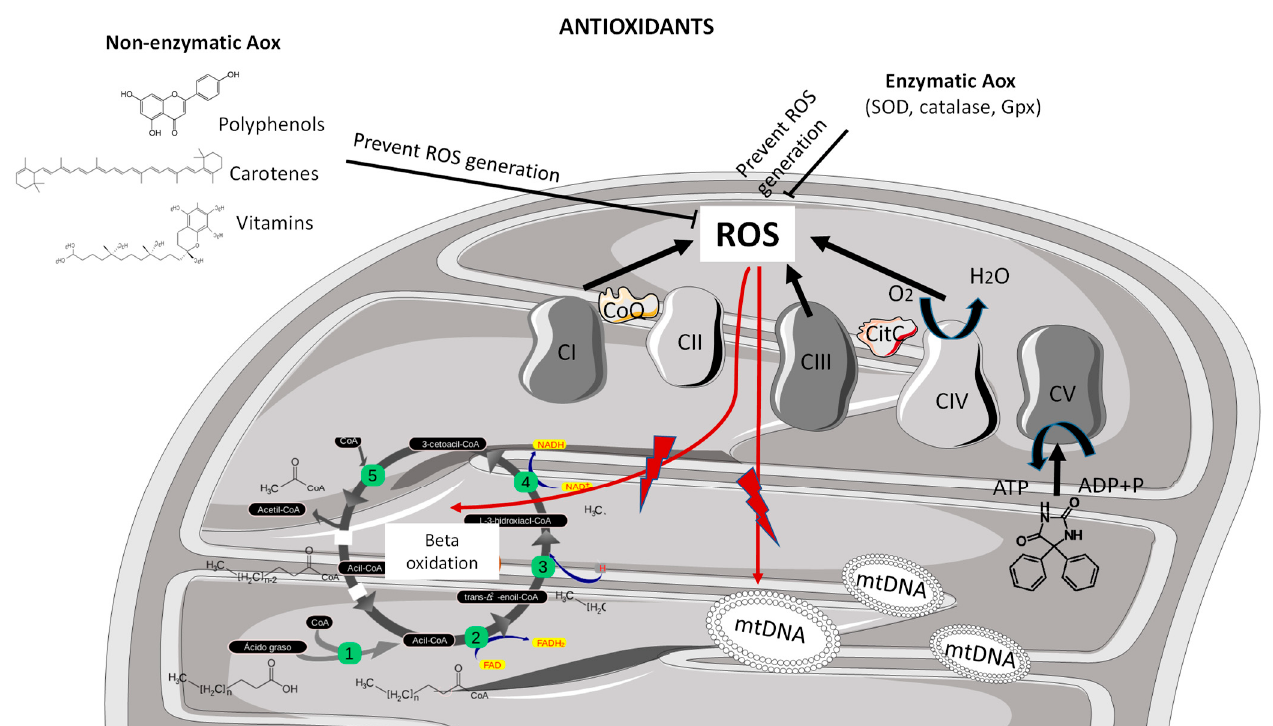
Figure 1. Mitochondrial generation of ROS and antioxidant mechanism of action. Mitochondrial- driven oxidative stress derived from suboptimal function at the level of complex I, complex III and complex IV enzymatic activities of the mitochondrial respiratory chain. Reactive oxygen species may damage different cell structures and molecules including lipids, b-oxidation cycle compounds or nucleic acids such as mitochondrial DNA. Non-enzymatic antioxidants, including polyphenols, carotenes and vitamins, and endogenous enzymatic antioxidants, including superoxide dismutase, catalase and glutathione peroxidase, exert protective mechanisms by scavenging the ROS towards redox equilibrium. ADP, adenosine diphosphate; Aox, antioxidant; ATP, adenosine triphosphate; CI, complex I; CII, complex II; CIII, complex III; CIV, complex IV; CV, complex V; Gpx, glutathione peroxidase; mtDNA, mitochondrial DNA; ROS, reactive oxygen species; SOD, superoxide dis- mutase.